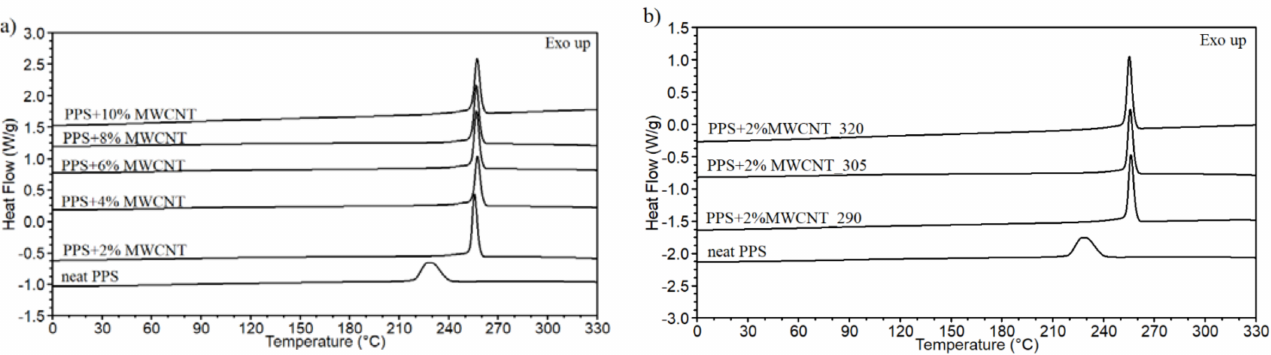
Figure 4. The cooling curves for the PPS/MWCNT composites. ( a ) Comparison of the MWCNT content. ( b ) Comparison of the extrusion